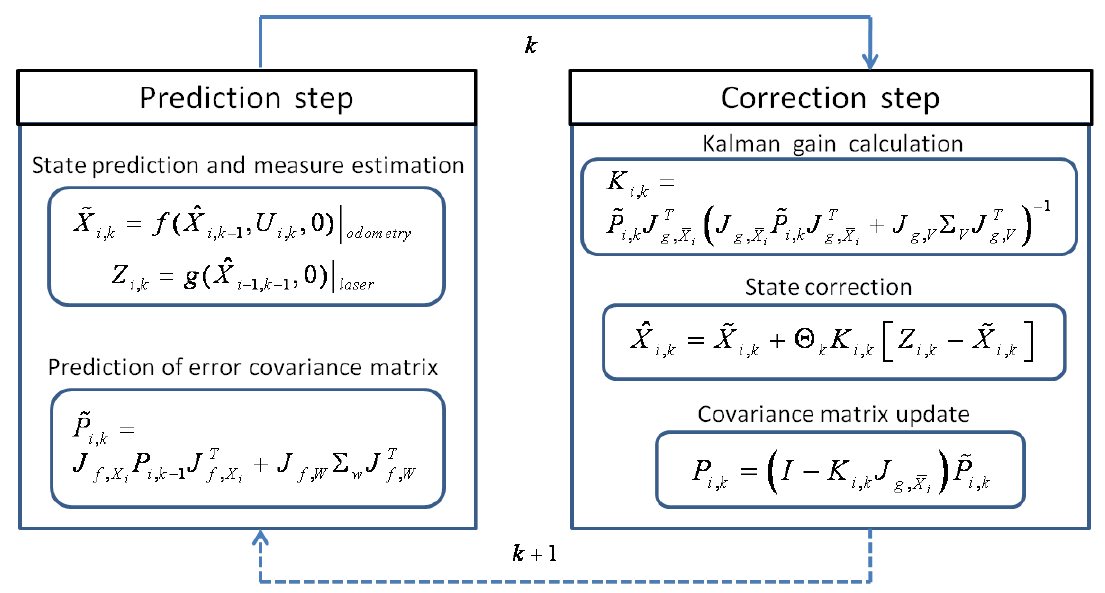
Figure 7. Block diagram of the implemented fusion algorithm, based on the standard